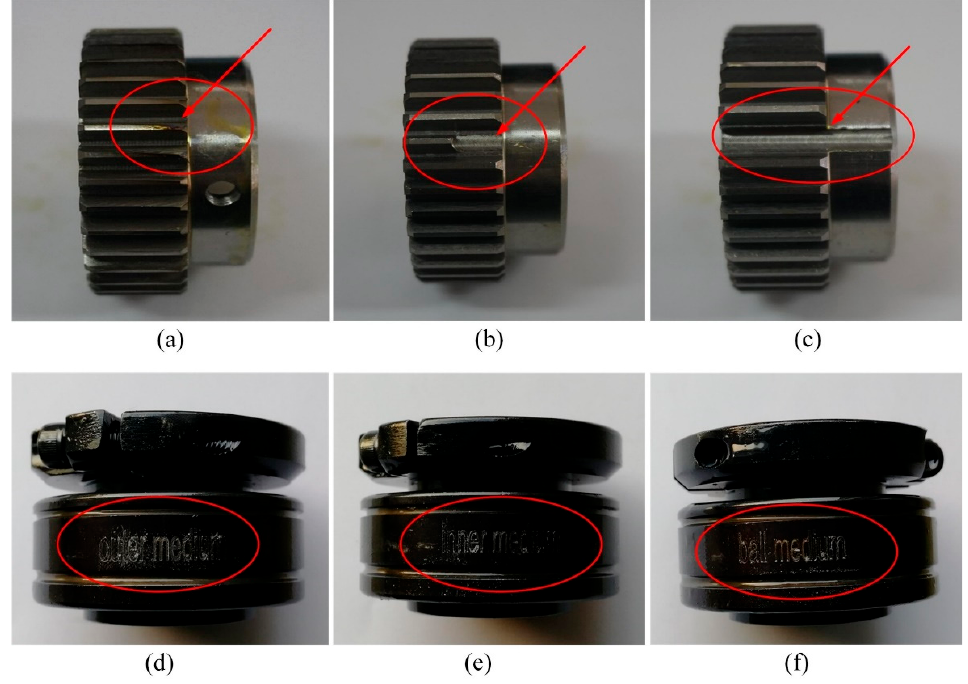
Figure 13. ( a ) Missing gear; ( b ) broken gear; ( c ) uniform worn gear; ( d ) bearing outer fault; ( e ) bearing inner fault; ( f ) bearing rolling ball fault. Table 4. Gear and bearing fault status